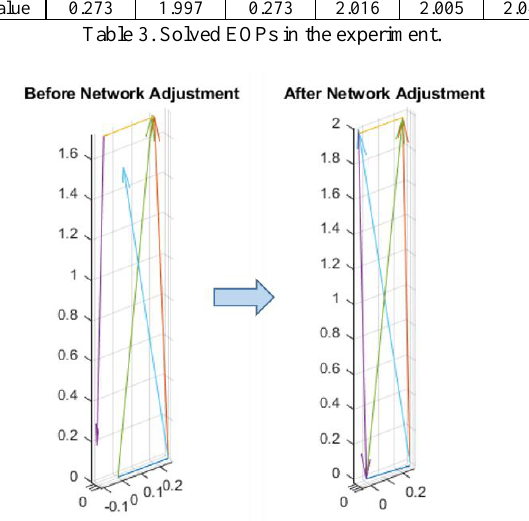
Figure 13. The difference of ROPs before and after applying network adjustment in the